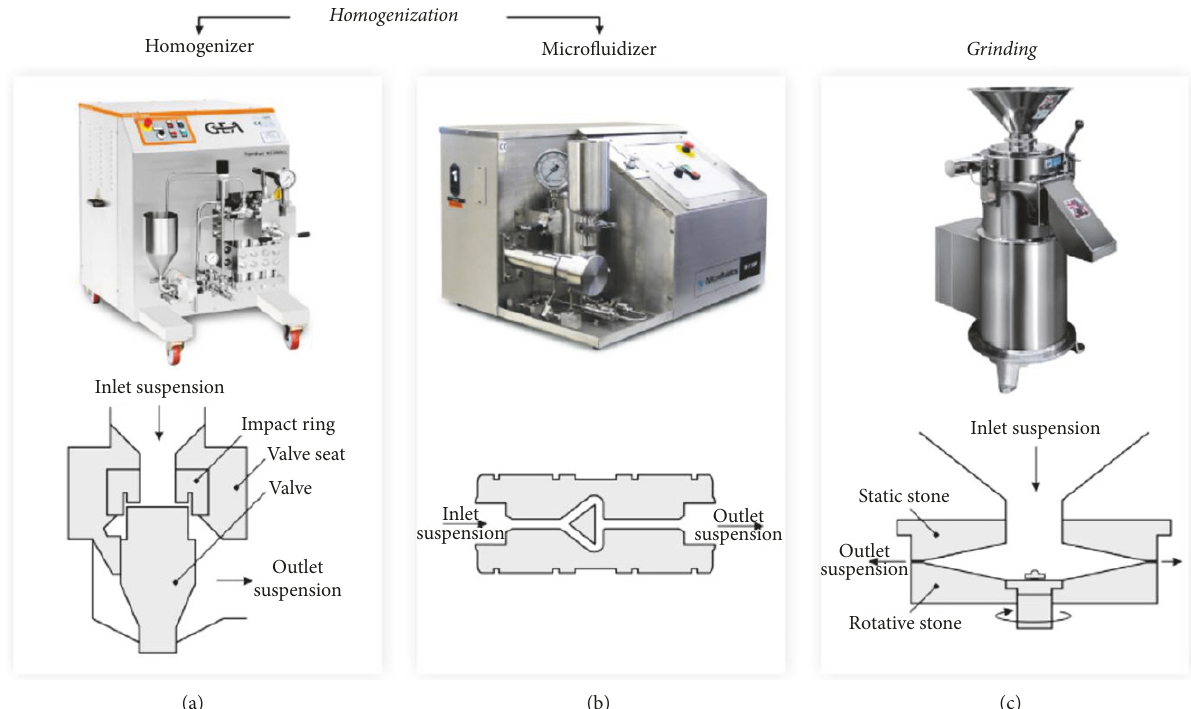
Figure9:ThemostappliedmechanicaltreatmentprocessesusedinthefabricationofCNFsandtheirschematicdiagram:(a)homogenizer,(b) microfluidizer, and (c) grinding. The photographs were adapted from [14], https://www.niro-soavi.com, https://www.microfluidicscorp.com and